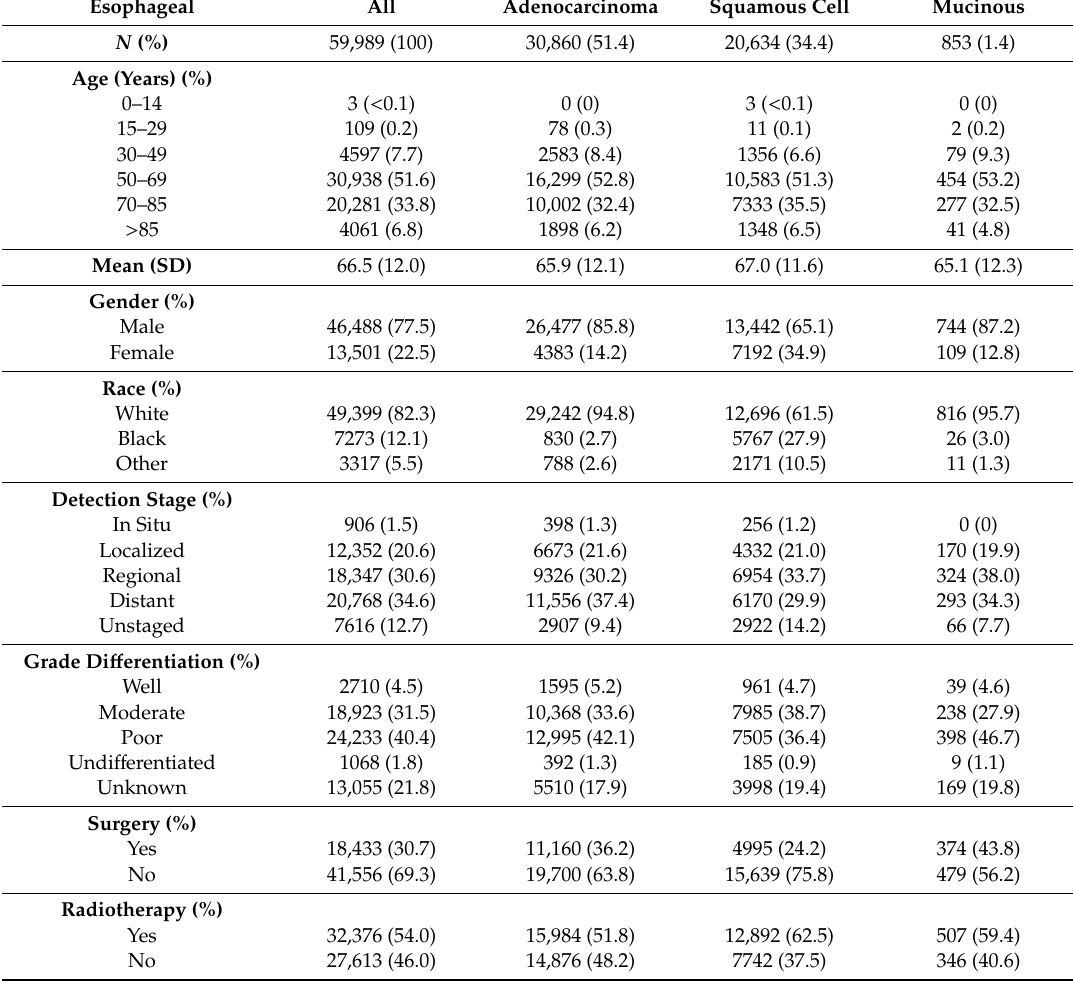
Table 19. Baseline demographics and clinical characteristics by histology for esophageal cancers. Esophageal All Adenocarcinoma Squamous Cell